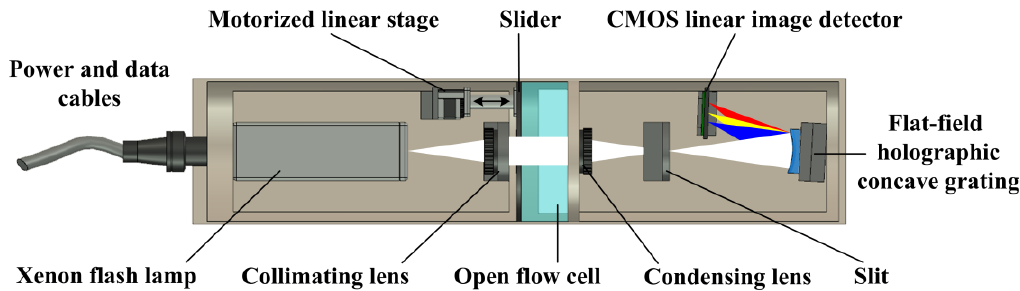
Figure 1. The structure of the UV-visible spectrometer probe with adaptive optical path.